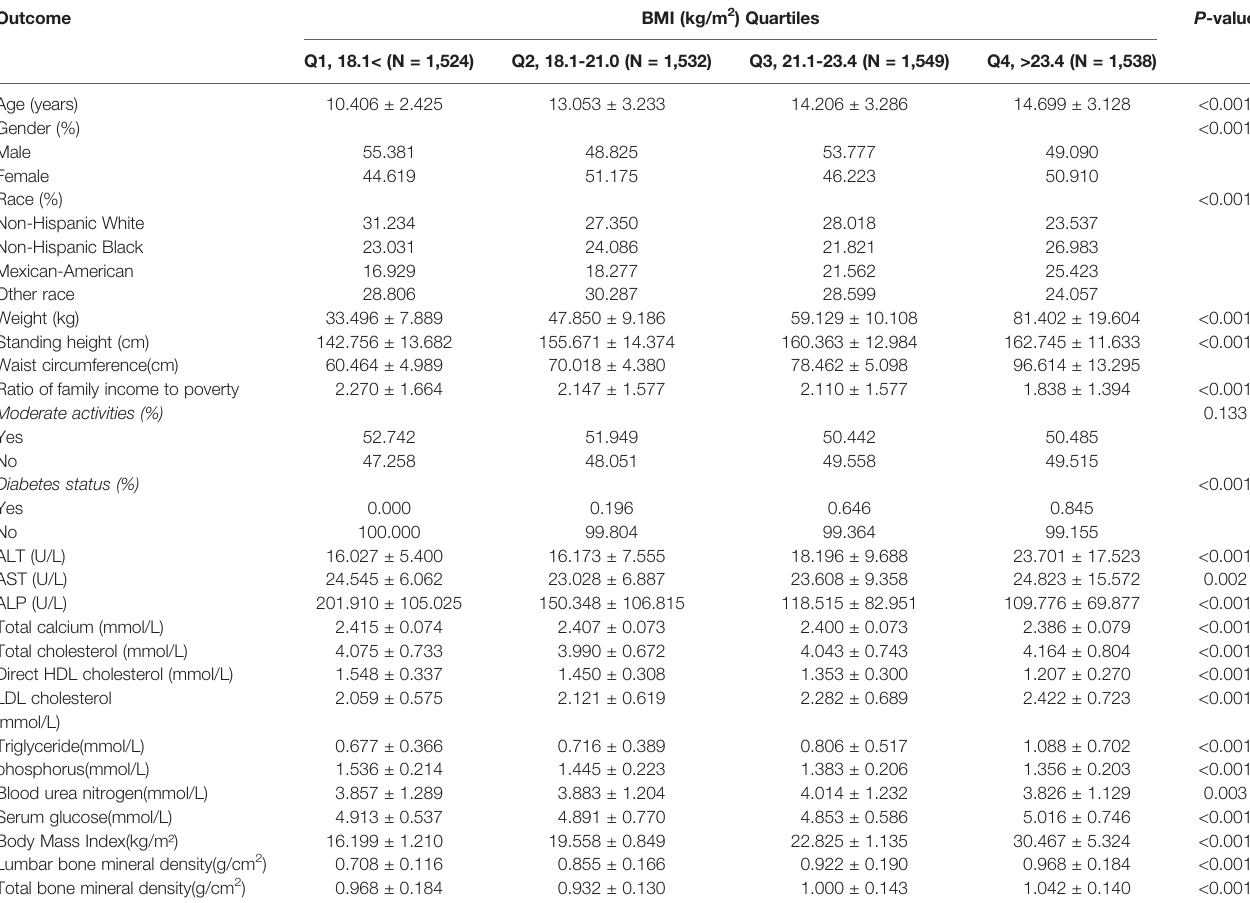
TABLE 1 | Characteristics of the participants. Outcome